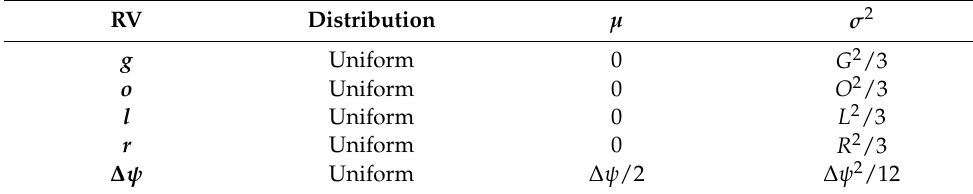
Table 1. Summary of the characteristics of the